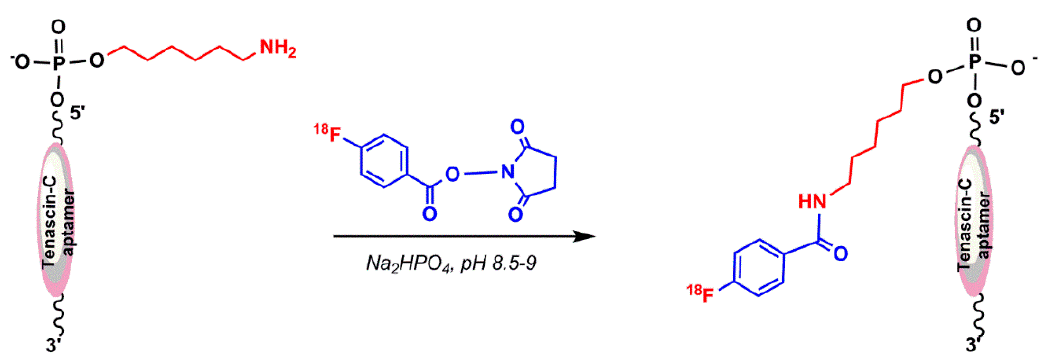
Figure 13. Conjugation of 18 F–SFB to a Tenascin ‐ C aptamer.